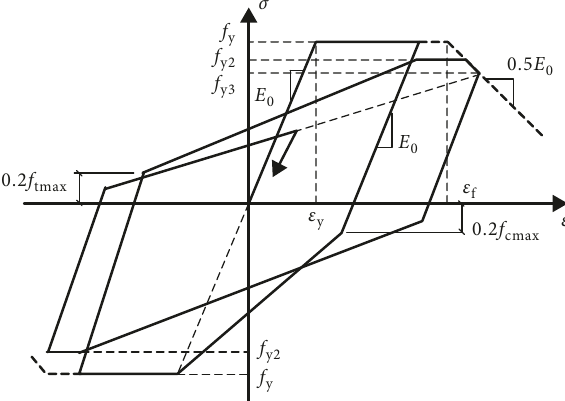
Figure 15: Constitutive model of steel material.